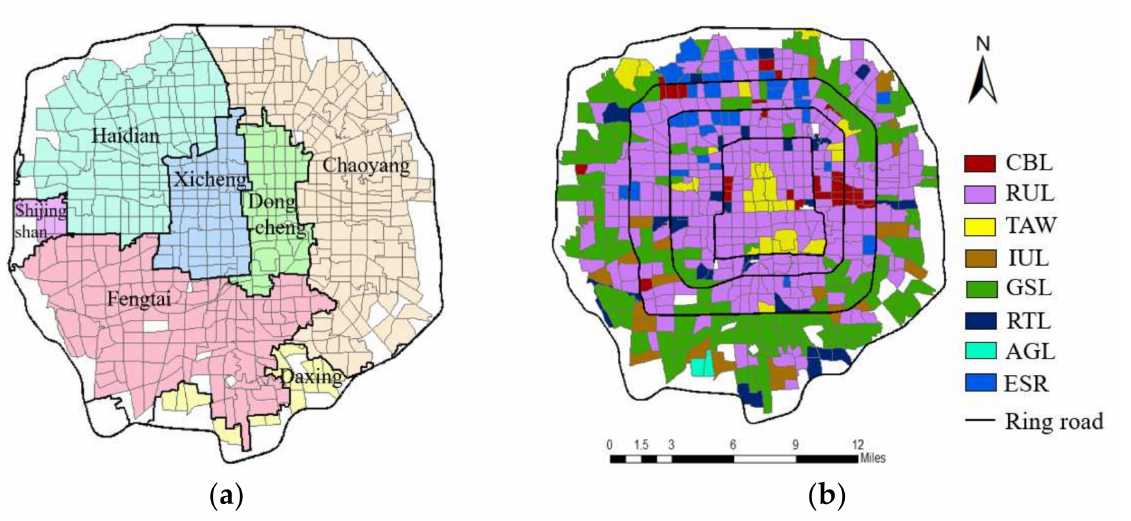
Figure 4. Study area. ( a ) Traffic analysis zones and administrative boundaries; ( b ) Beijing land use planning map